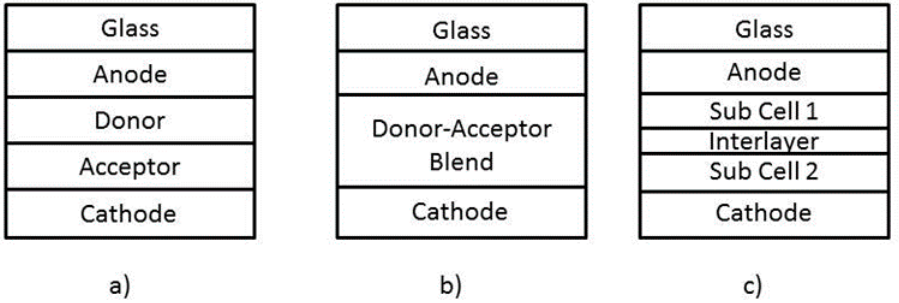
Figure 8. Different types of multiple layer solar cells: ( a ) Bilayer heterojunction, ( b ) Bulk heterojunction and ( c ) Tandem heterojunction [179]. and ( c ) Tandem heterojunction